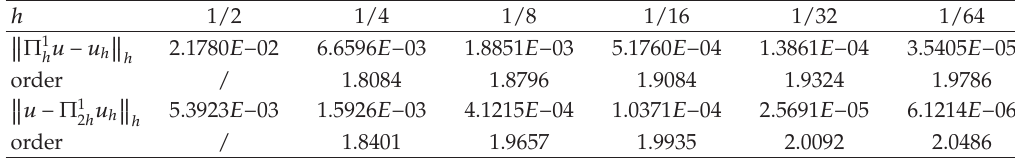
Table 1: The error estimates for conforming FE scheme.